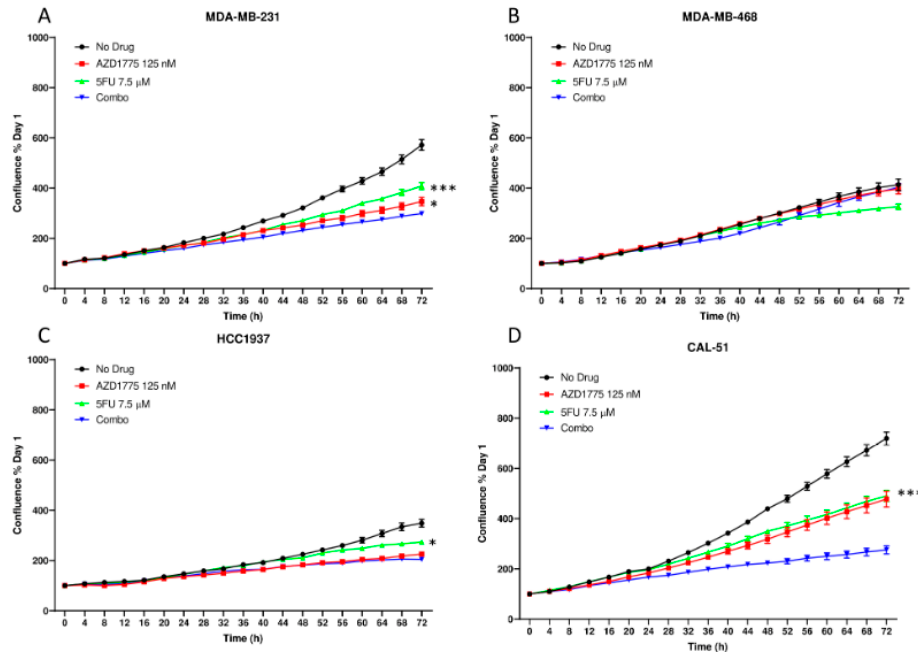
Figure 3. Anti-proliferative effects of AZD1775 and 5FU in TNBC cell lines. Cells were treated with AZD1775 and 5FU and proliferation was assessed for 72 h using the Incucyte Zoom and normalized to Day 1. ( A ) MDA-MB-231, ( B ) MDA-MB-468, ( C ) HCC1937, and ( D ) CAL-51. A t-test was performed to compare the combination treated to each of the single agent (* = p < 0.05, *** = p < 0.001).